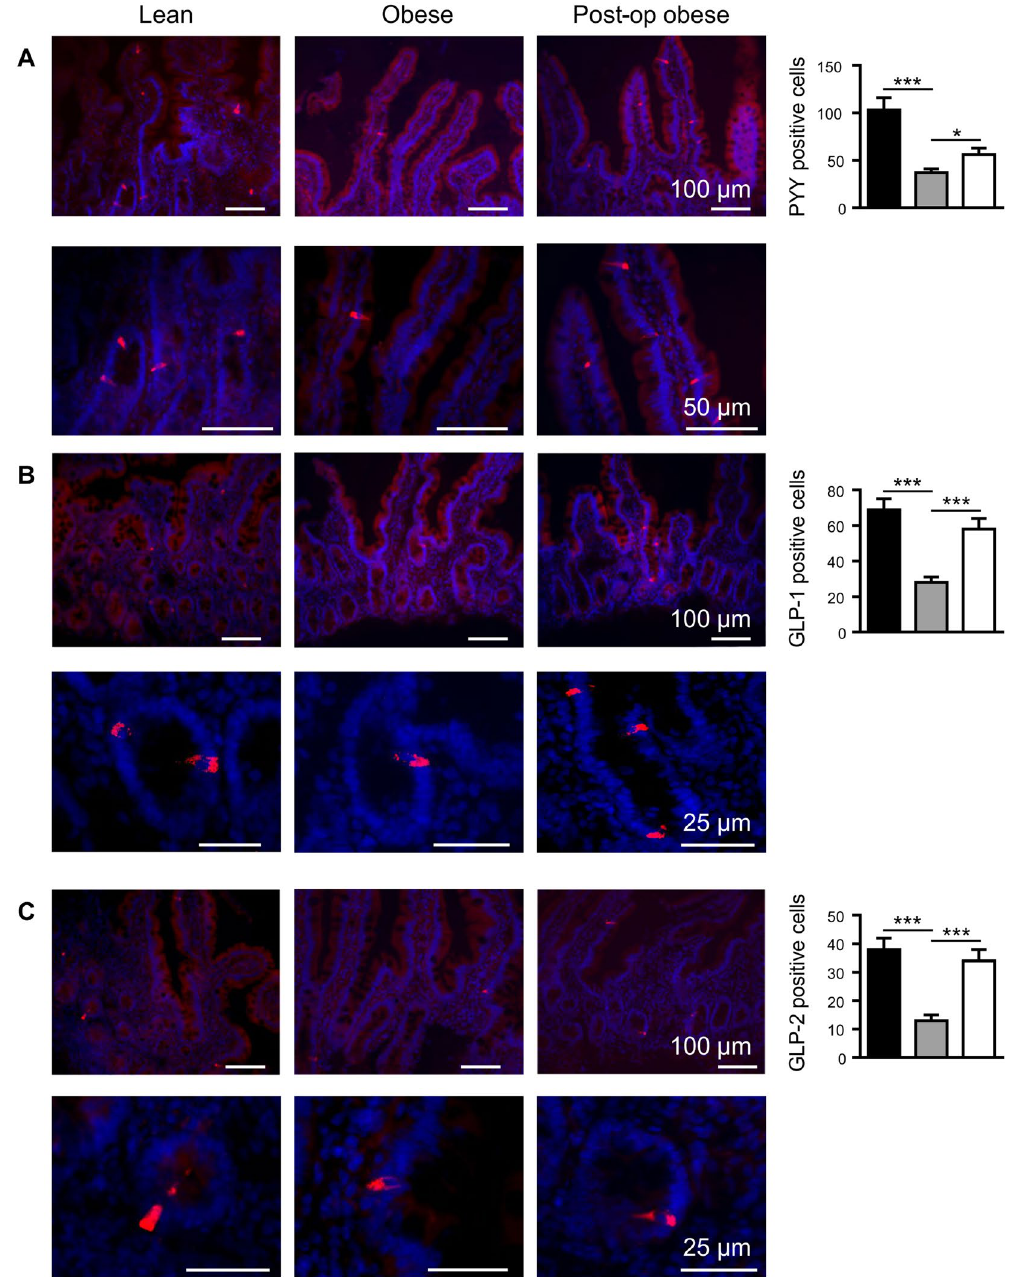
Figure 3. PYY, GLP-1 and GLP-2 protein expression in human duodenal biopsies. Profile of gut hormones, PYY ( A ), GLP-1 ( B ) and GLP-2 ( C ) was determined in the duodenal biopsies of lean ( ■ ), obese ( ) and post- operative obese, ( □ ) by immunohistochemistry. Bar charts (on the right) show number of cells counted expressing the gut hormones. Statistical significance was determined by a One-way ANOVA with differences between means identified using a Holm-Sidak multiple comparison post-test test where * p < 0.05, *** p < 0.001. Scale bars are either 100, 50 or 25 µ m. Nuclei are stained blue with 4 ′ ,6-diamidino-2-phenylindole